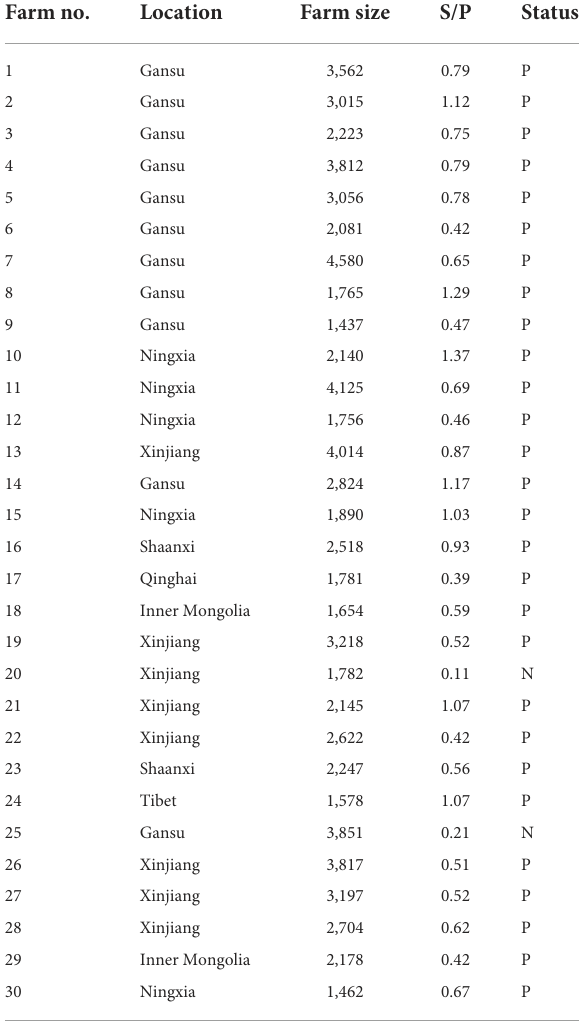
TABLE 2 Detection results of BTM BVDV antibody by ELISA in western China. Farm no.